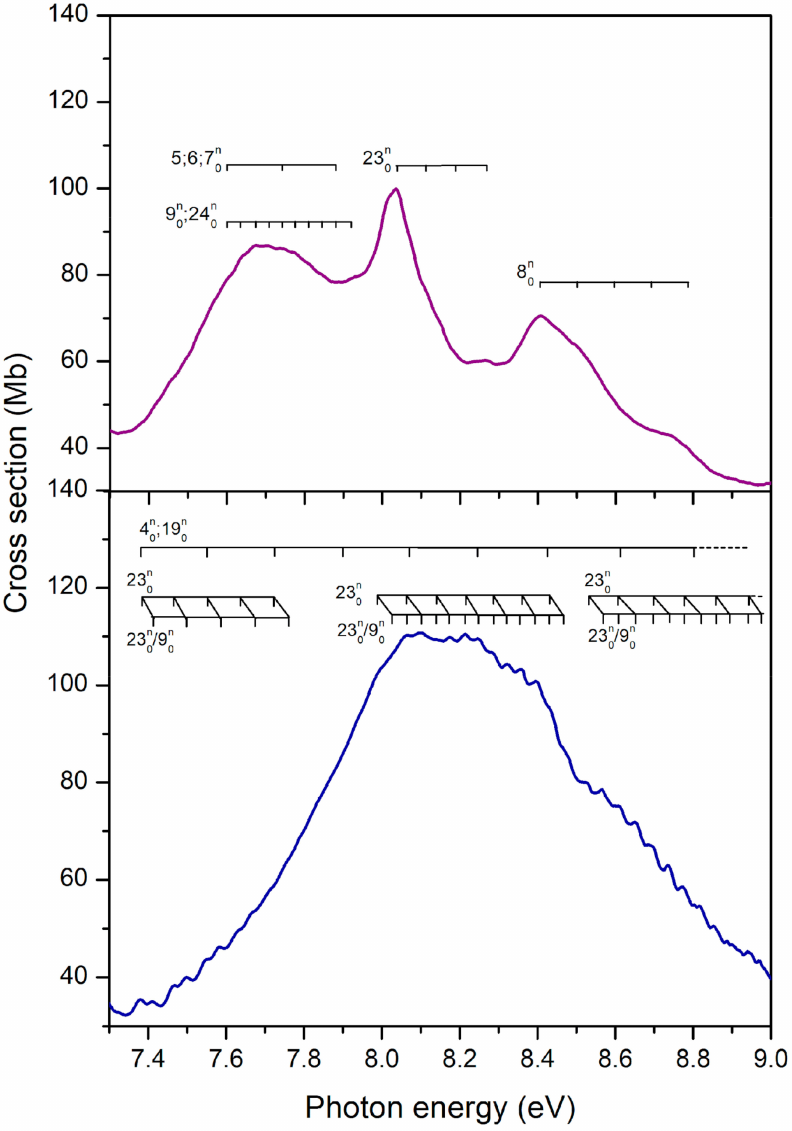
Figure 11. Vibrational progressions in the 7.2–9.0 eV energy range of the absorption Band V of 2-bromopyrimidine ( top panel) and 5-bromopyrimidine ( bottom panel). In 5BrPyr, the band is centered at 8.2 eV, and is assigned to π *(a 2 ) ← π Br (b 1 ) + π *(b 1 ) ← π (a ← π π *(b 2 ) (f 0 = 0.32) and 1 ) Br (b 1 ) (f 0 = 0.15) excitations, vertically located at 8.18 and 8.28 eV according to the calculations. Two vibrational progressions were identified and tentatively attributed to excitation of the C–Br stretching ( υ 9 ) and ring stretching ( υ 23 ) modes (see Table 5). Another progression with an average spacing of 0.180 eV (1452 cm − 1 ) was also identified, and could be related to either υ 4 or υ 19 ring stretching